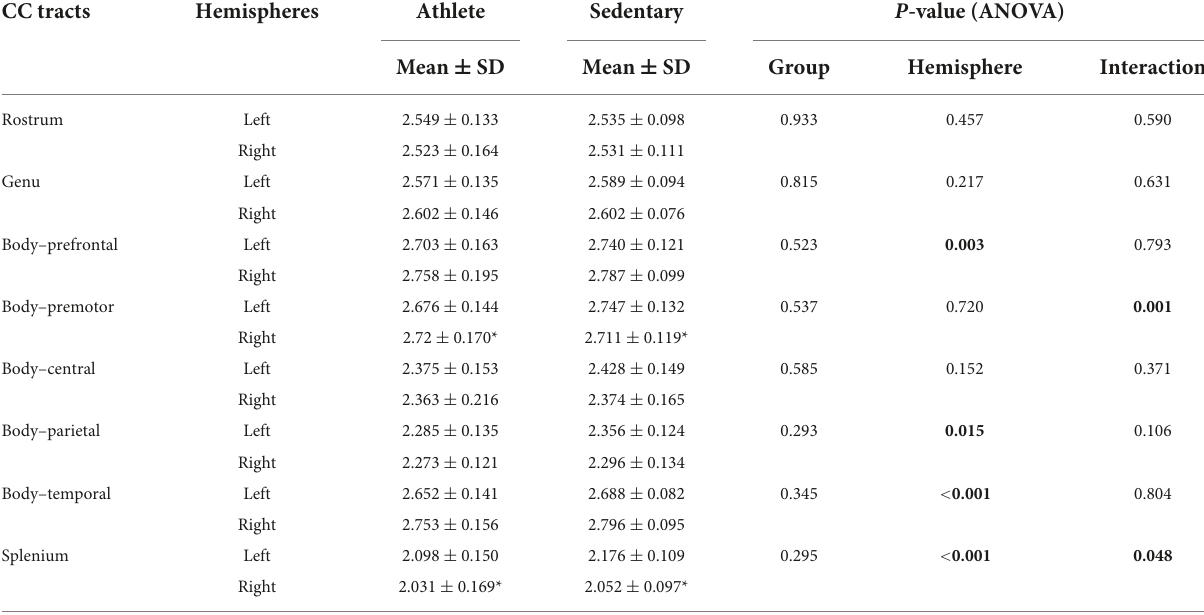
TABLE 4 Cortical thickness of the corpus callosum (CC) tract endpoints compared between the athlete and sedentary